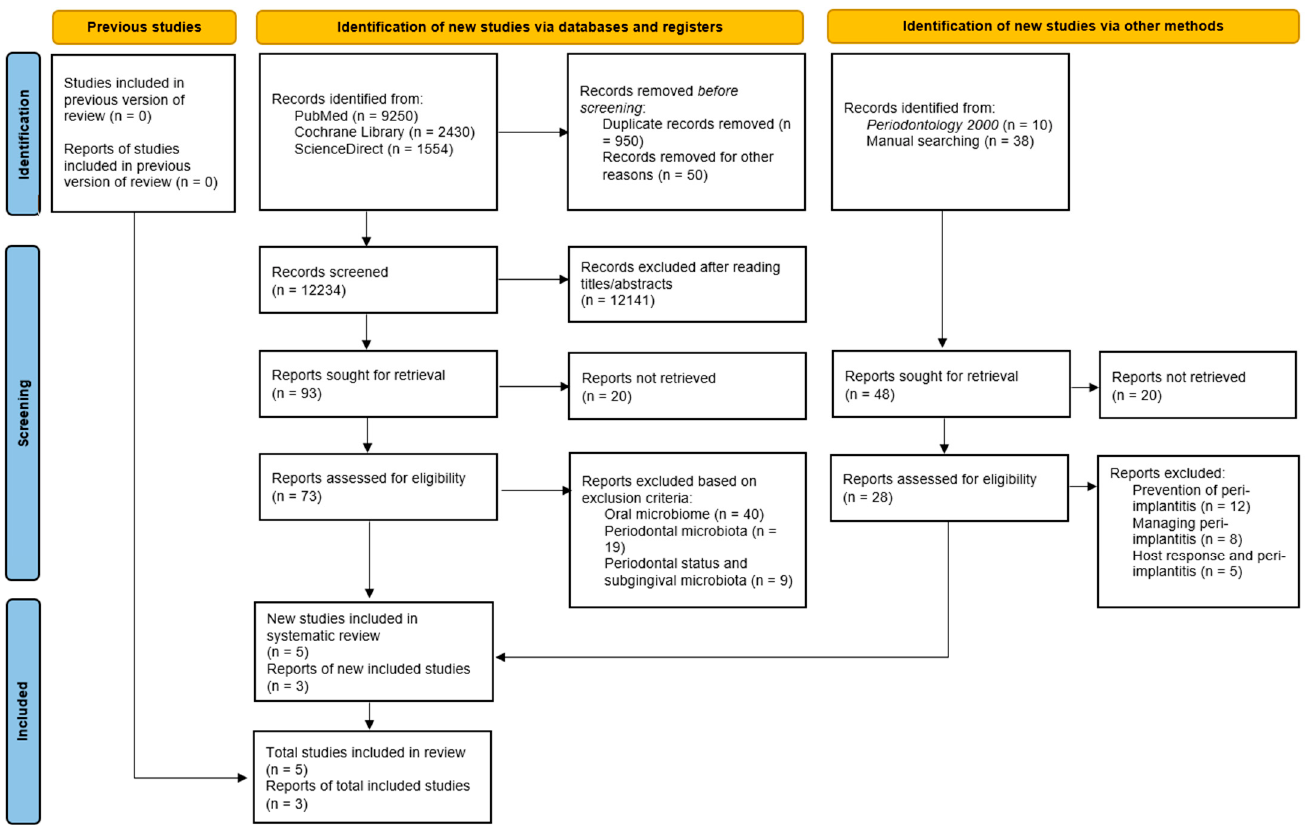
Figure 1. Flow diagram of the current systematic review.